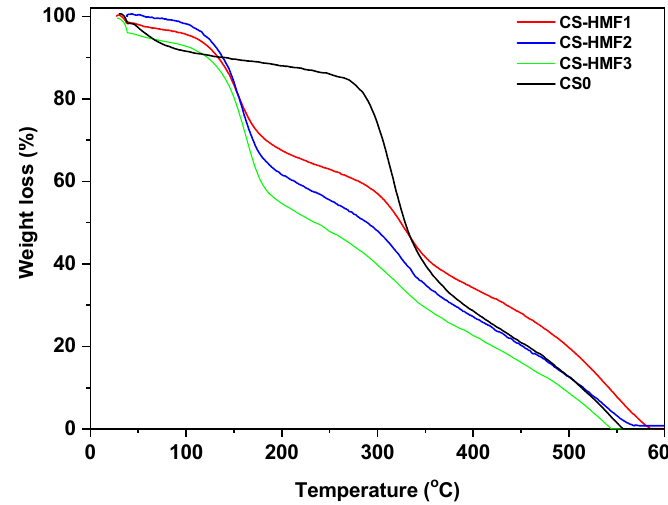
Figure 4. TGA analysis of the metal-loaded CS-HMF derivatives.